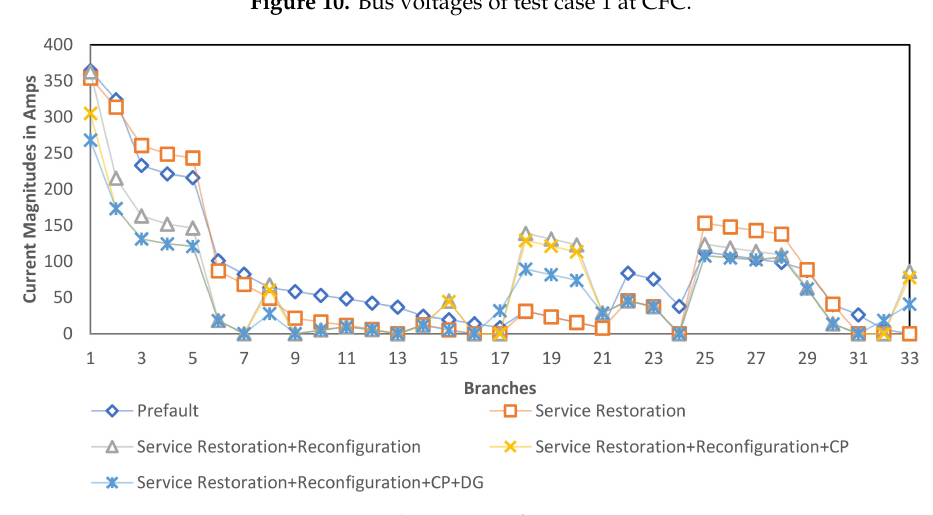
Figure 10. Bus voltages of test case 1 at CFC.